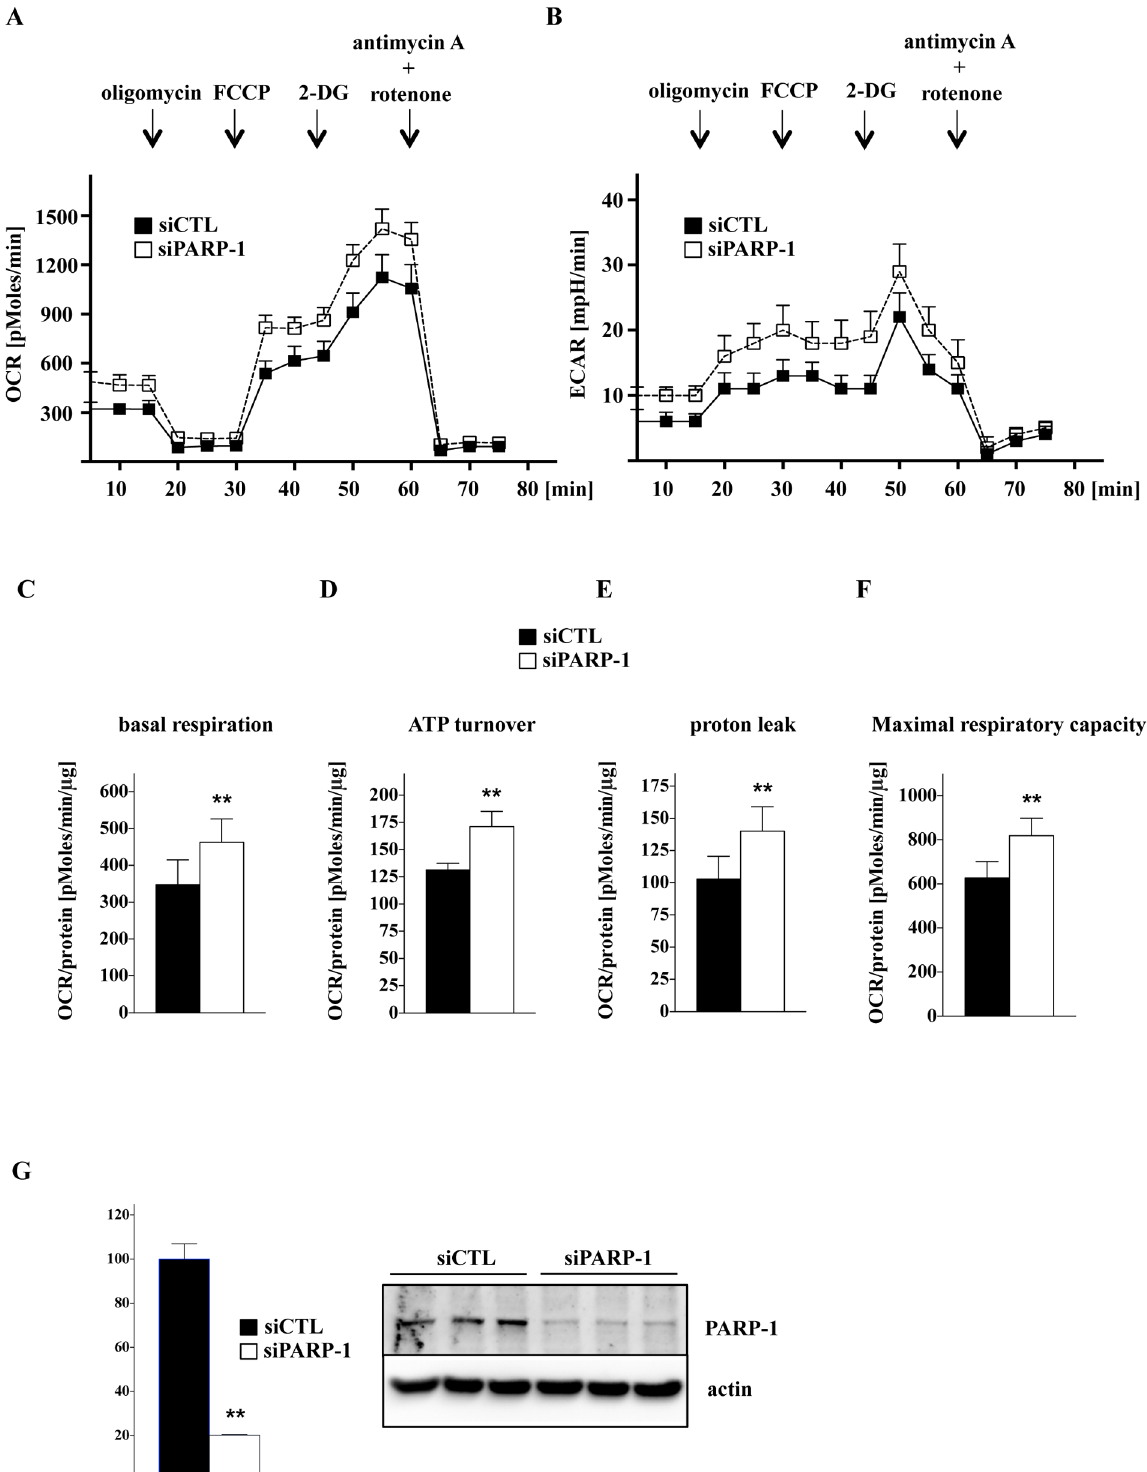
Fig 10. Silencing PARP-1 increases both oxidative phosphorylation and glycolytic activity of C2C12 myoblasts. Bioenergetic analysis of the myoblasts was conducted by extracellular flux analysis. In the figure, a time-course measurement of OCR (A) and ECAR (B) for 1×10 4 cells/well under basal conditions was followed by the sequential addition of oligomycin (1 μ g/ml), FCCP (0.3 μ M), 2-DG (5mM) and antimycin A (2 μ g/ml). Cells with PARP-1 silencing show significantly elevated OCR values during basal and uncoupled respiration ( * p < 0.05). (C, D, E, F) Major bioenergetic parameters are elevated